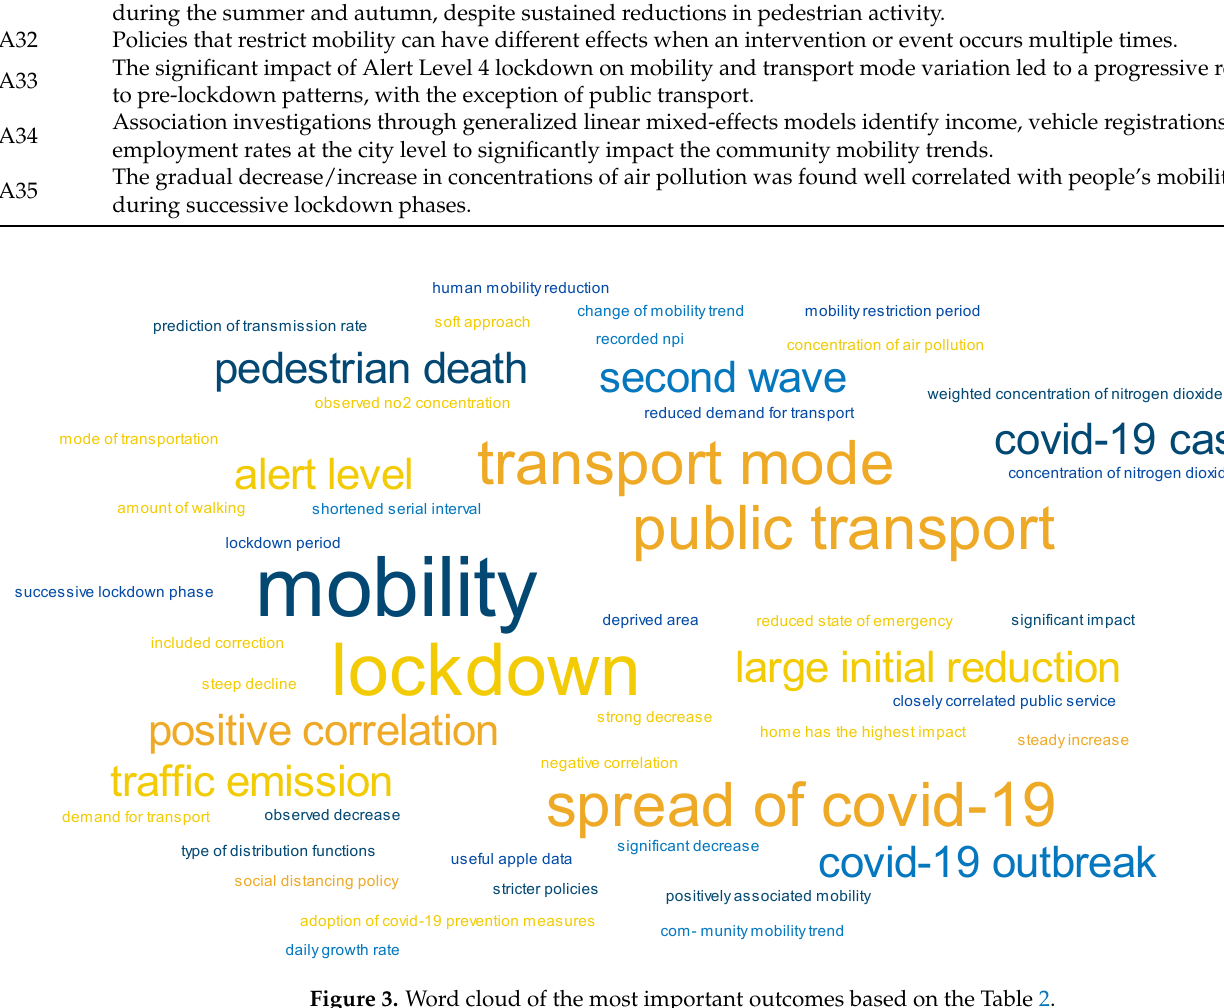
Figure 3. Word cloud of the most important outcomes based on the Table 2.